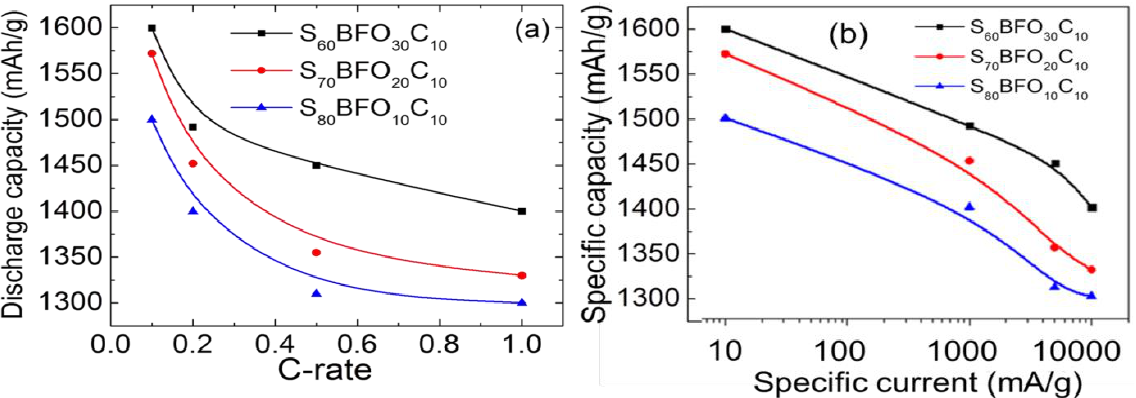
Figure 6. ( a ) C-rate versus discharge capacity and ( b ) Specific capacity versus specific current for BFO – C-Sulfur composite cathode materials.